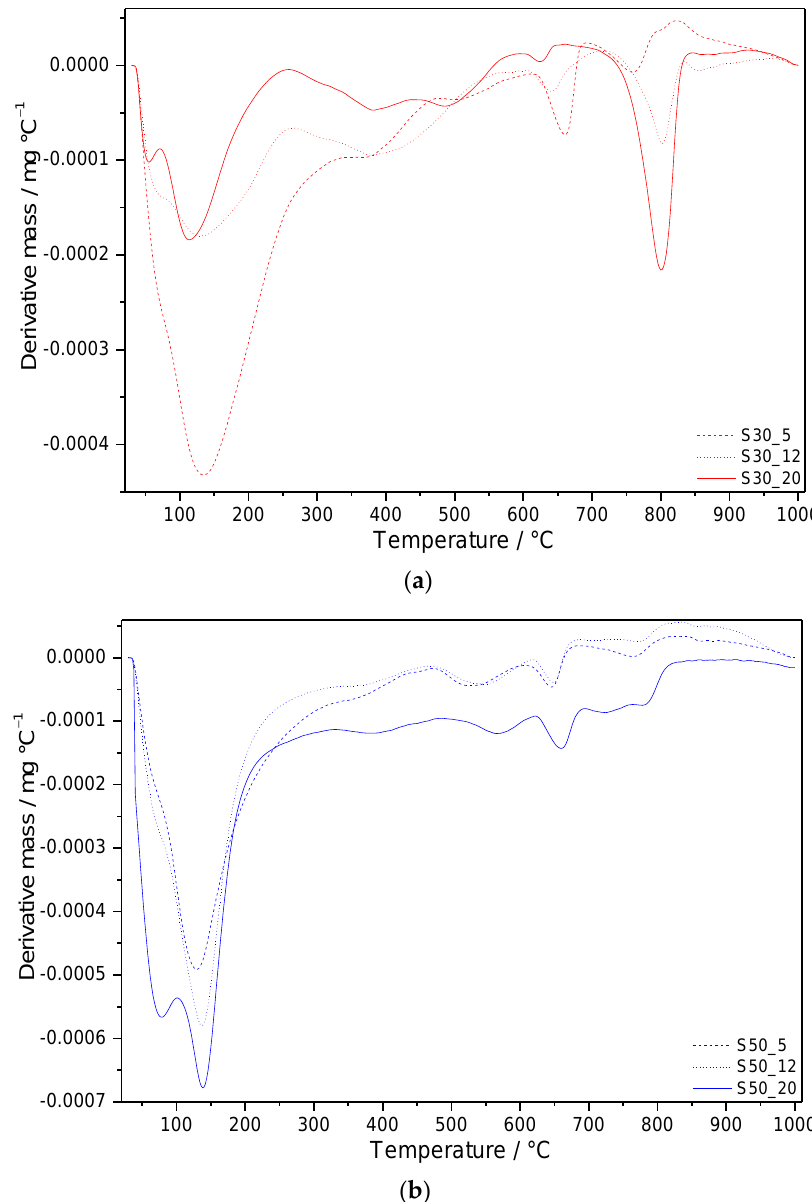
Figure 7. DTG curves of samples with ( a ) 30 mass% SF and ( b ) 50 mass% SF addition after 7 days of hydrothermal curing.